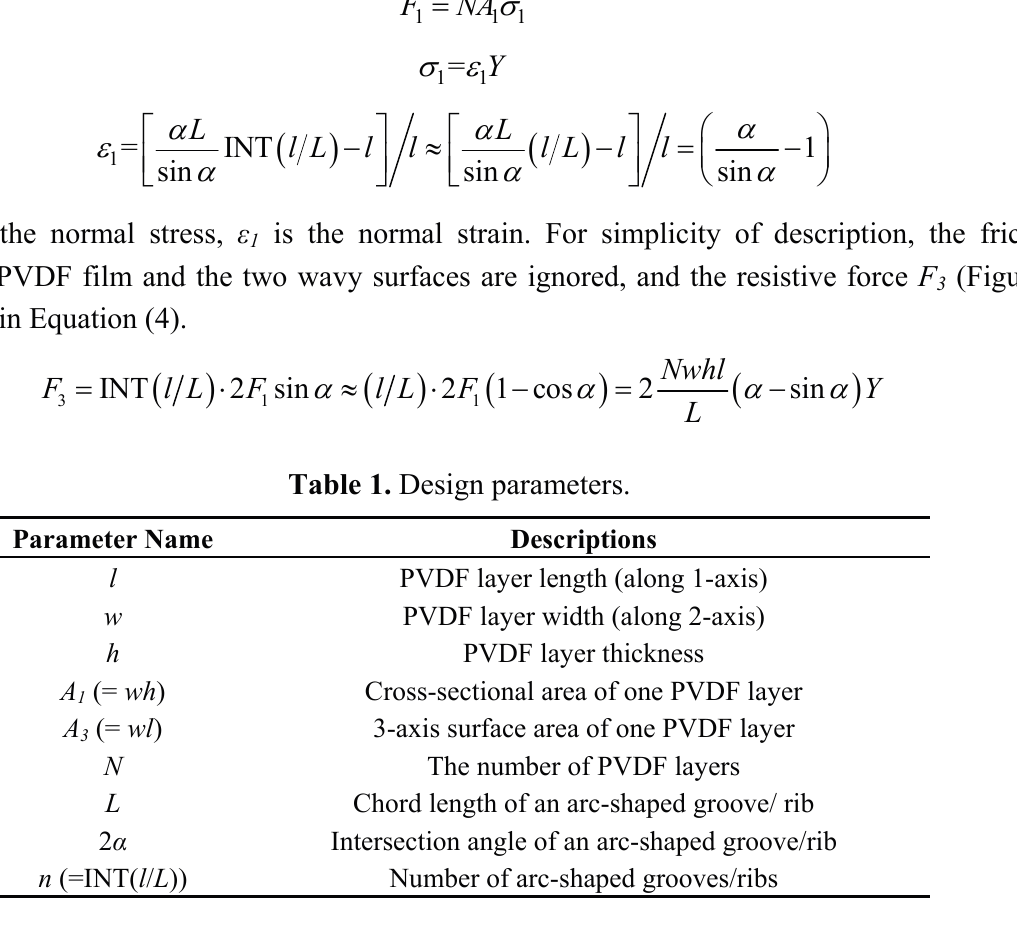
Figure 2. The resistive force F